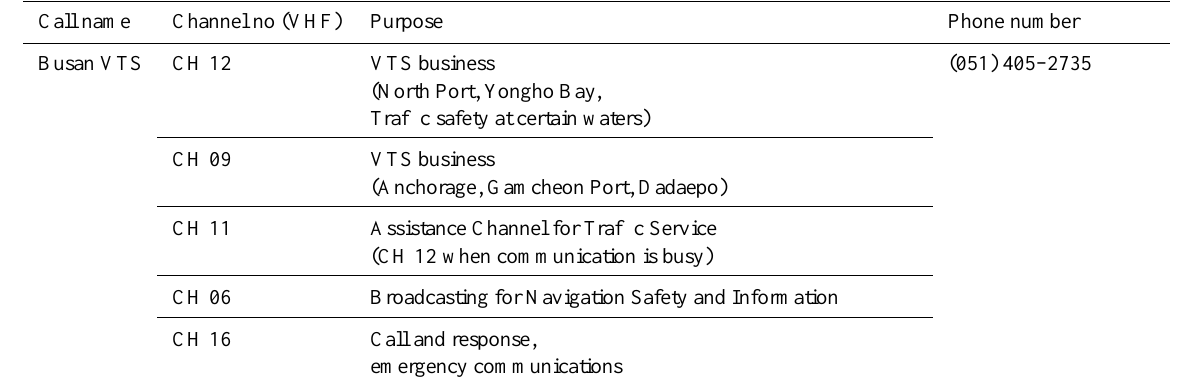
Table 4. The system of the vessel traffic services center at Busan Port.